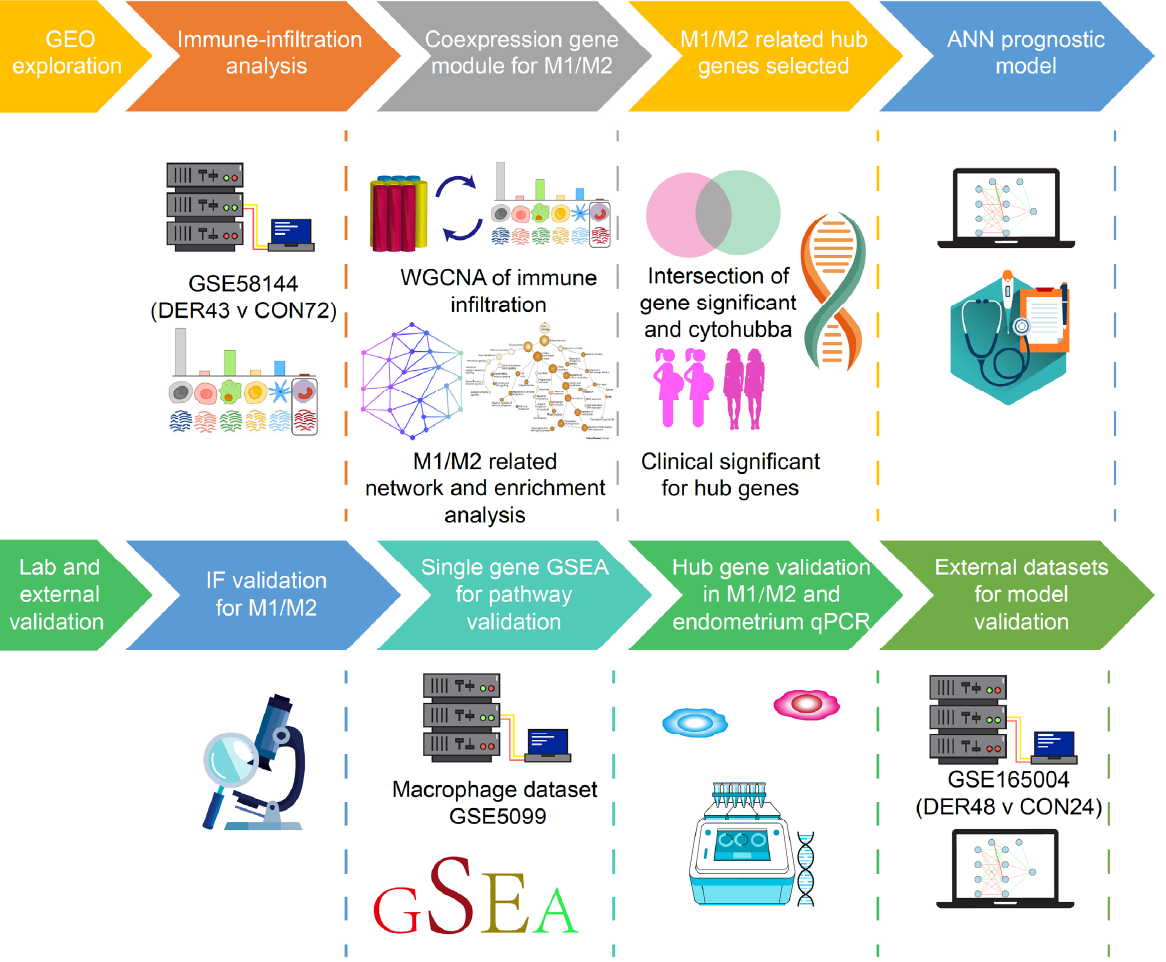
Figure 1. Schematic presentation of the study design. DER = defective endometrial receptivity, IF = Immunofluorescence, ANN = artificial neural network and GSEA = Gene-set enrichment analysis.